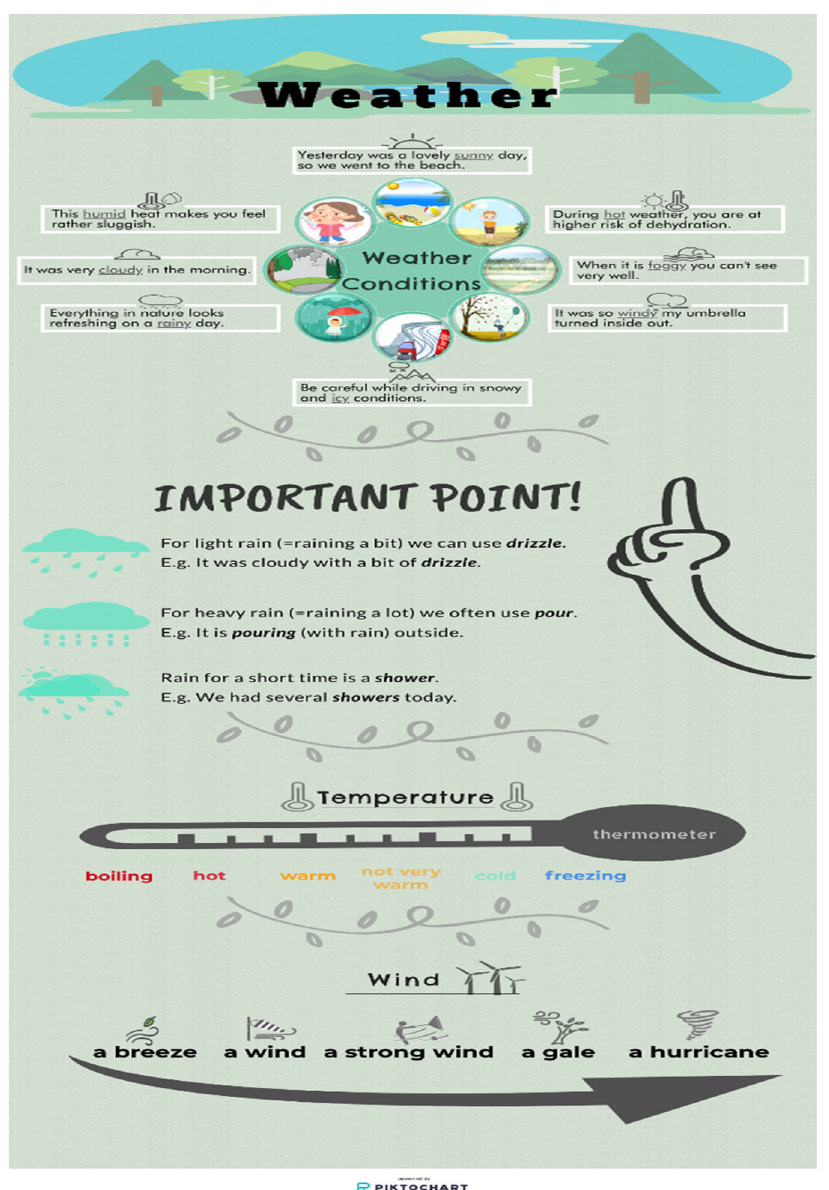
Fig. 2 Screenshot of the infographics used in the